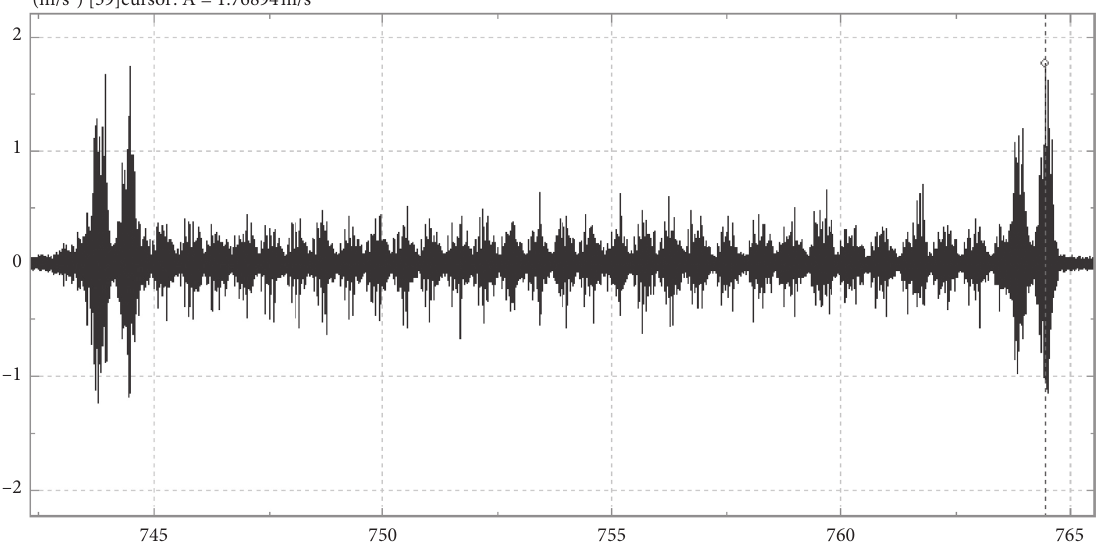
Figure 16: Time domain characteristic diagram of vibration acceleration along the line direction ( Y -axis) in the intact